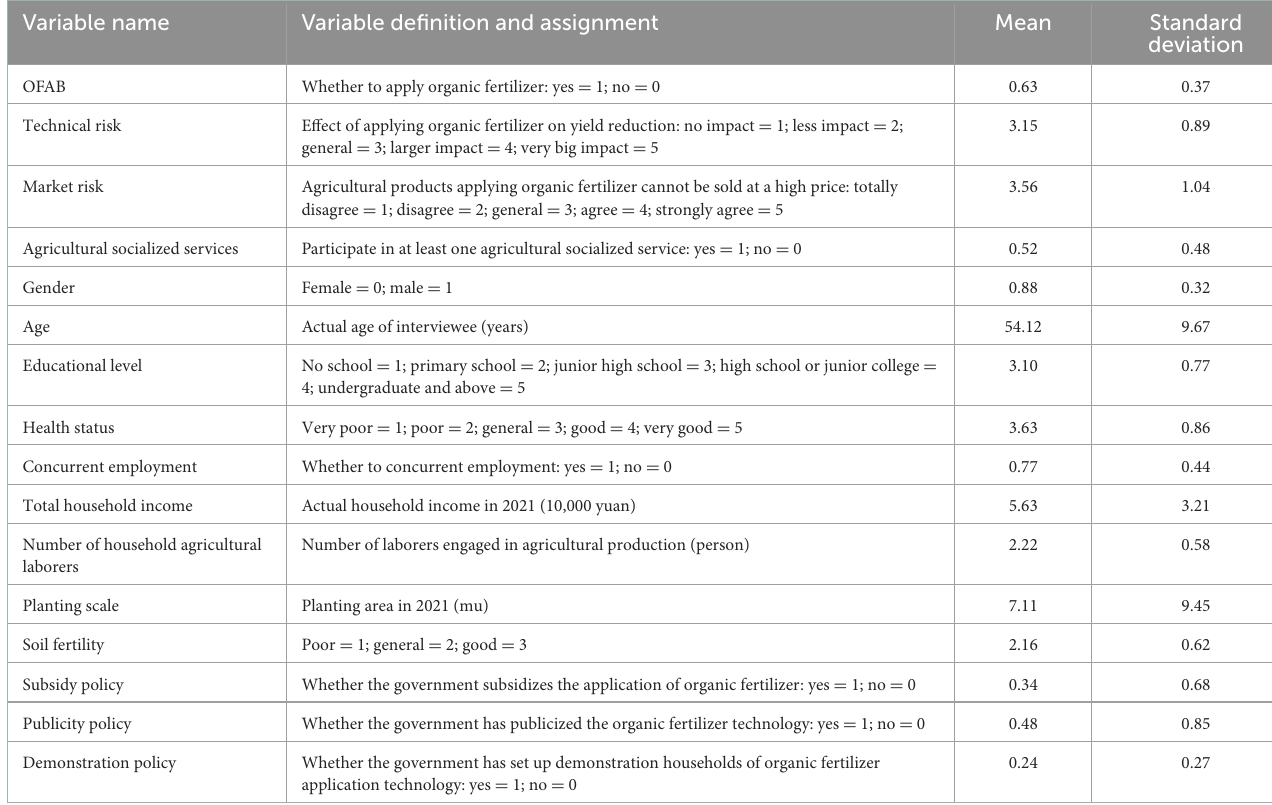
TABLE 2 Variable definition and descriptive statistics.